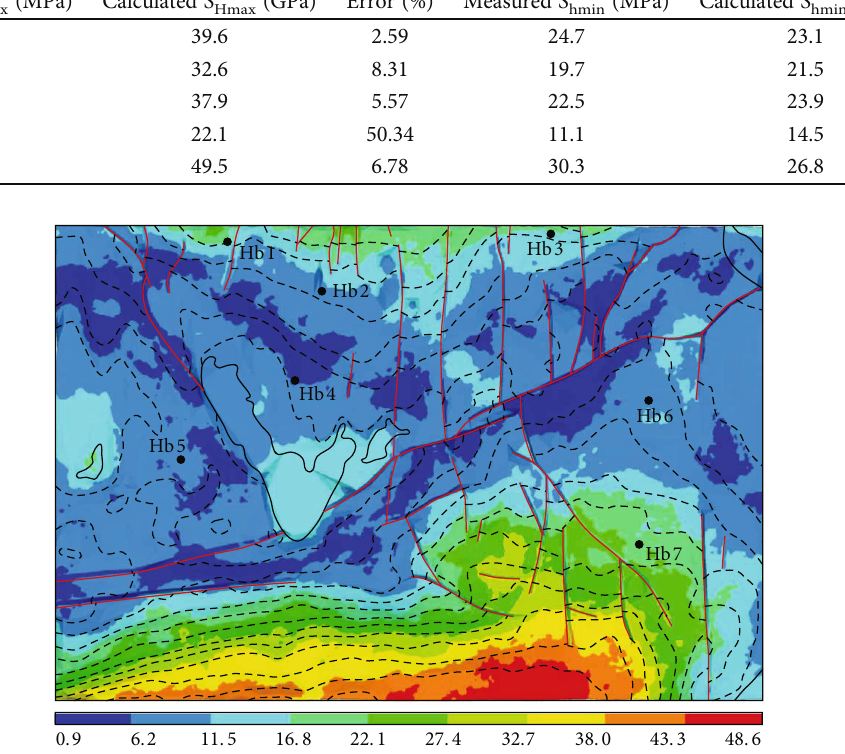
Table 2: Error analysis of the measured and calculated stress results from numerical simulation.